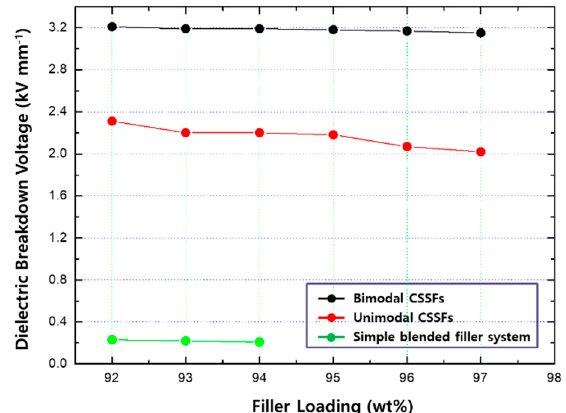
Figure 9. Comparison of the inter-decoupling ratio (IDR) of DFSs made of bimodal CSSFs, unimodal CSSFs, and simple blended filler systems.